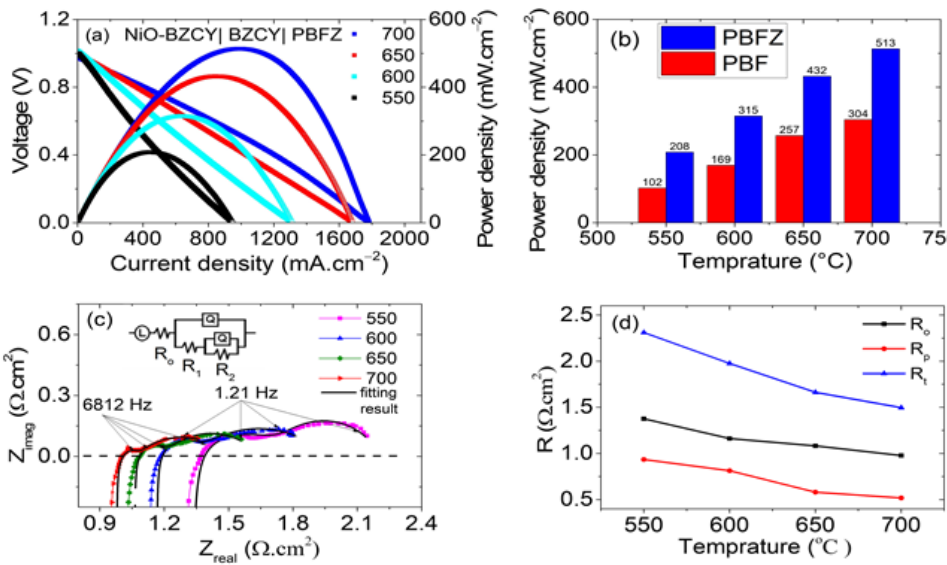
Figure 5. ( a ) I-V and I-P curves of single cells; ( b ) cell performance histogram; ( c ) impedance spectra of NiO-|BZCY|PBFZ; ( d ) Ohmic (R o ) polarization (R p ), and total (R t ) resistance of single-cell at different temperature.